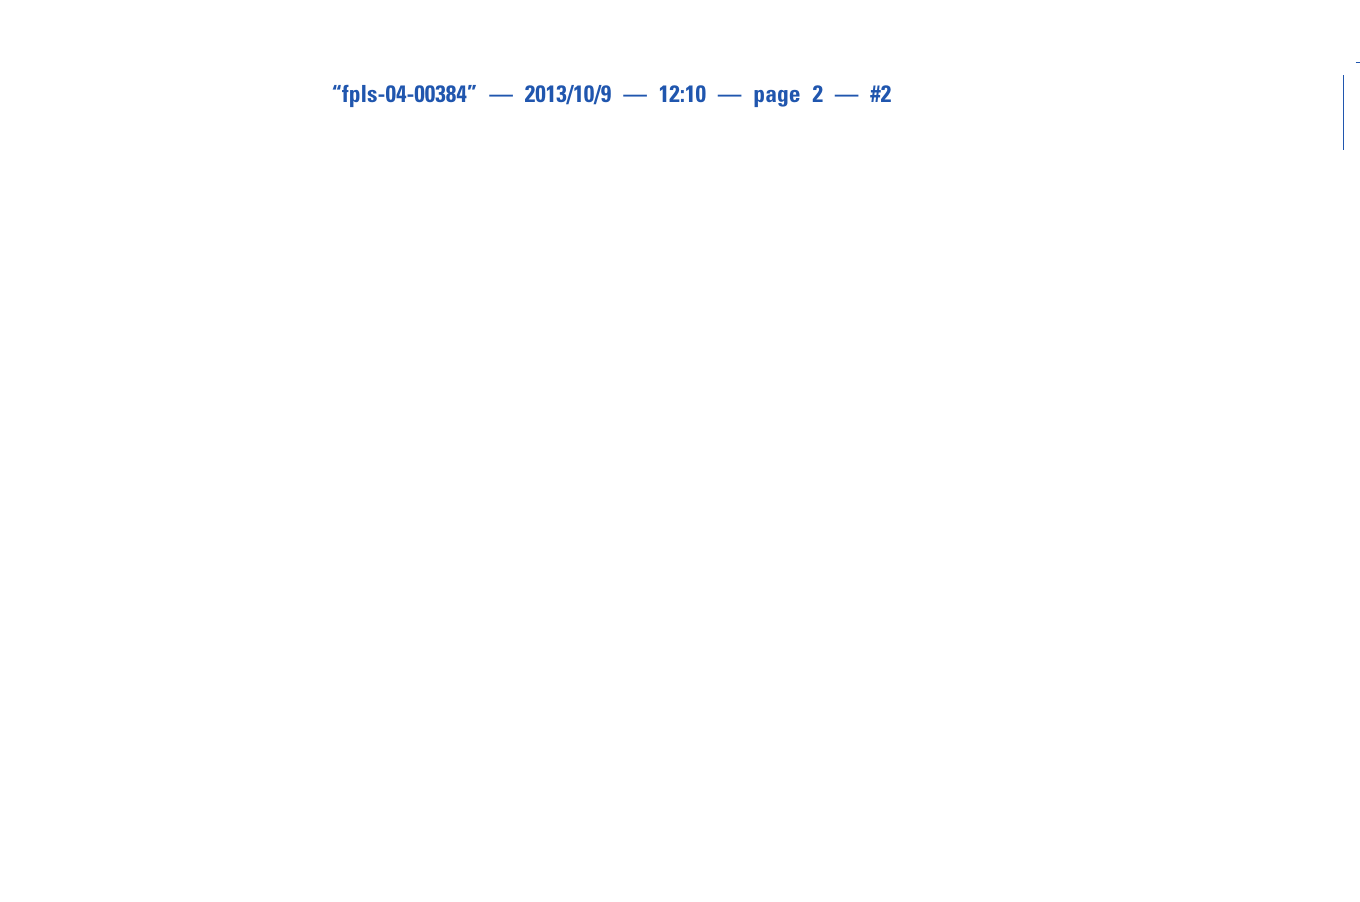
and nitrous oxide reductase (Nos). In the cytosol NO is oxidized into NO − 3 by the flavohemoglobin Hmp. The production of NO via a bacterial NOS-like is hypothetical. In both plant and bacteroid partners, ATP is synthesized due to transmembrane electrochemical gradient generated by proton (H + ) pumping at ETC level. NO − 3 , nitrate; NO − 2 , nitrite; N 2 O, nitrous oxide; NH + 4 , ammonium; Arg, arginine; Nif, nitrogenase; PBM, peribacteroid membrane; PBS, peribacteroid